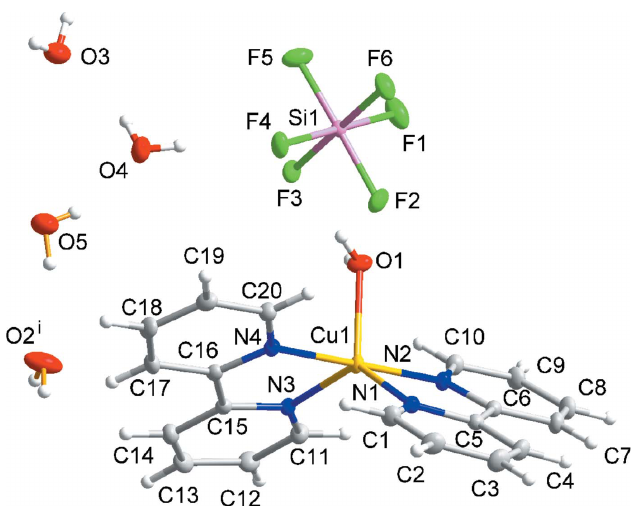
Figure 1 The molecular structure of (I). Ellipsoids of non-H atoms are drawn at 50% probability. H atoms are drawn with an atomic radius of 0.135 A˚ . [Symmetry code: (i) 1